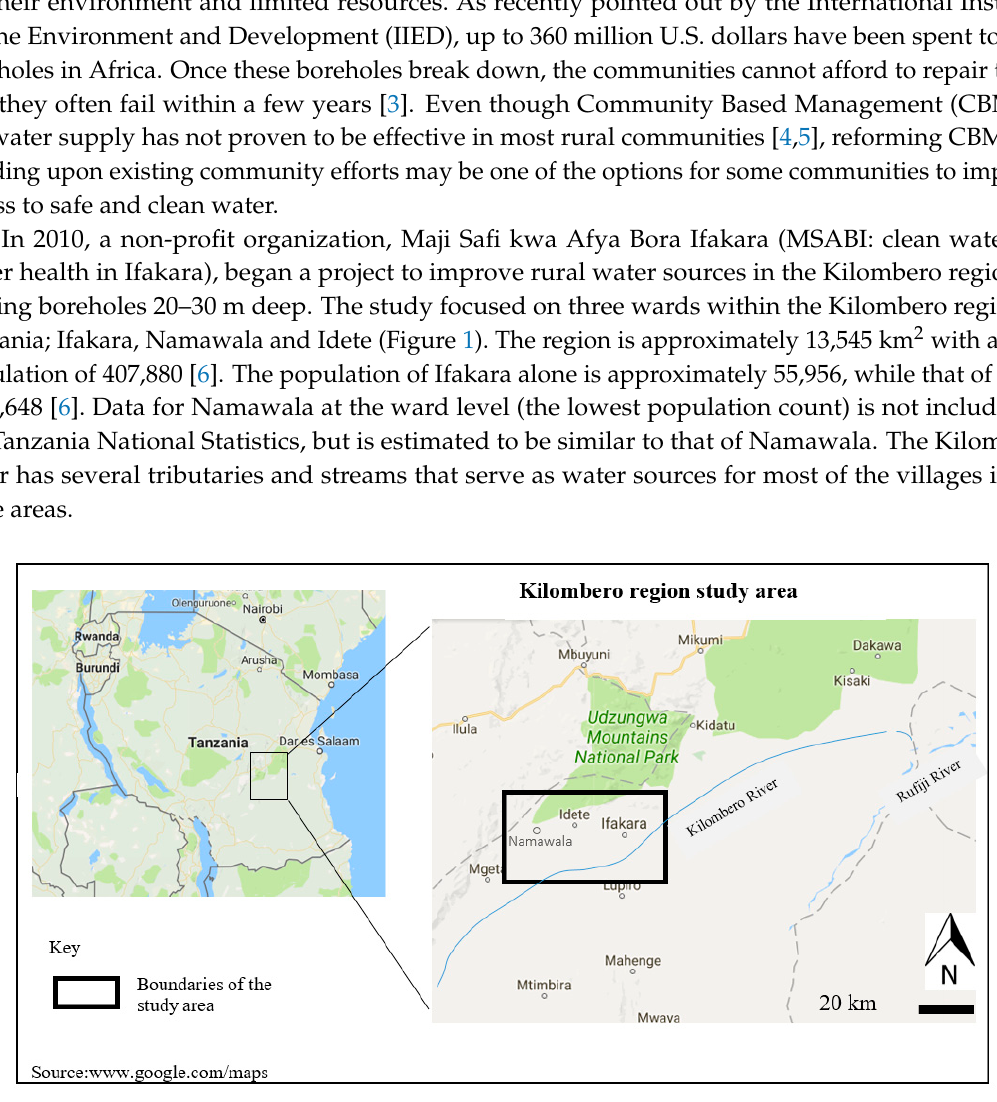
Figure 1. Map of the Kilombero region, Tanzania.